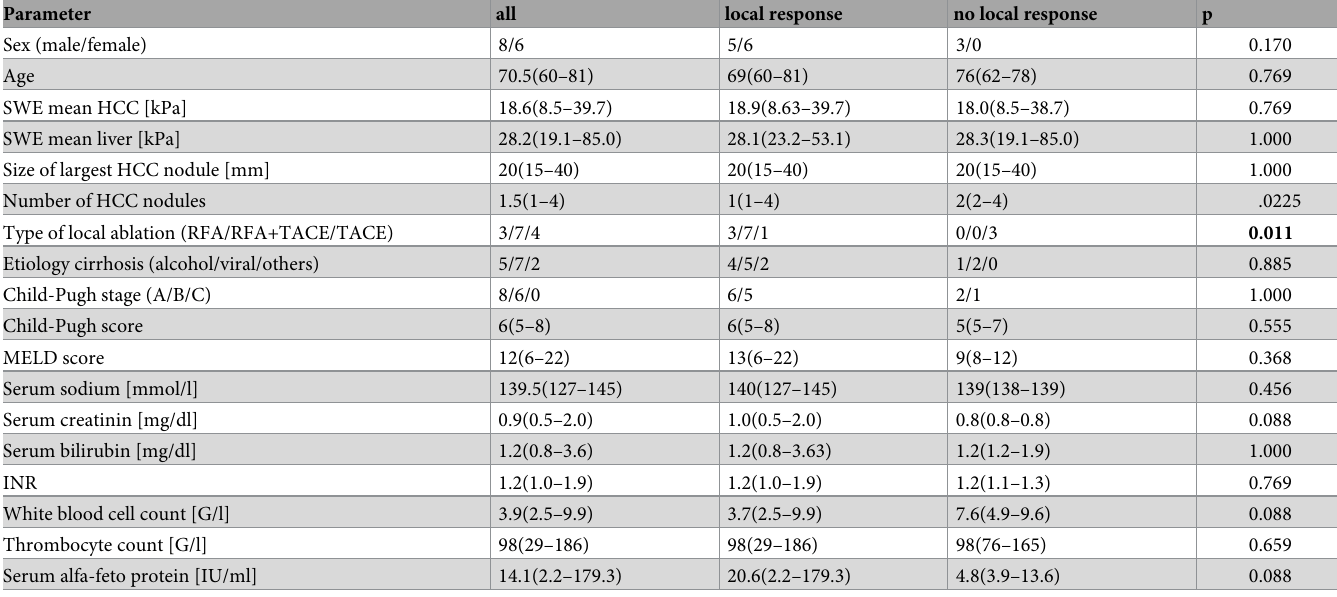
Table 2. Patient characteristics before local ablative therapy, stratified for local